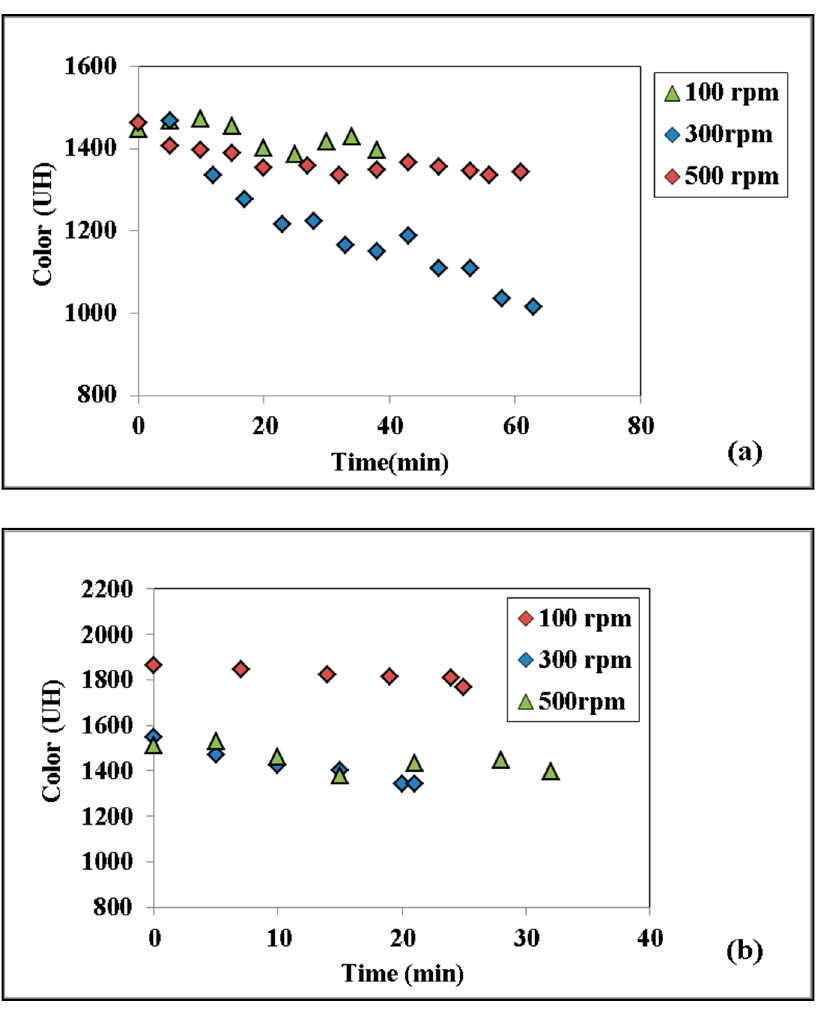
Figure 1. Textile WW color variation in time at three different rotational speeds and a WW flowrate of ( a ) 10 L/h, ( b ) 30